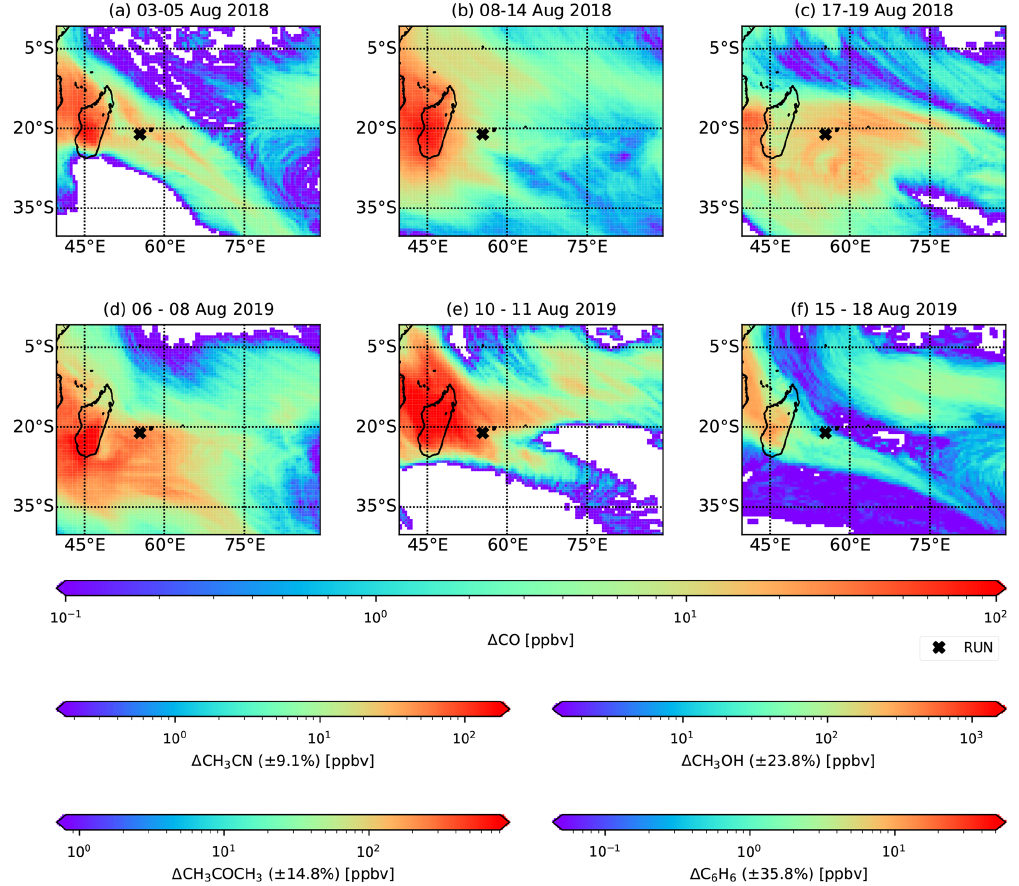
Figure 5. Excess CO over the south-west Indian Ocean between 0 and 500ma . g . l . from BB emissions as simulated by FLEXPART. Addi- tional colour scales quantify the projected CH 3 CN, CH 3 COCH 3 , C 6 H 6 and CH 3 OH excesses.